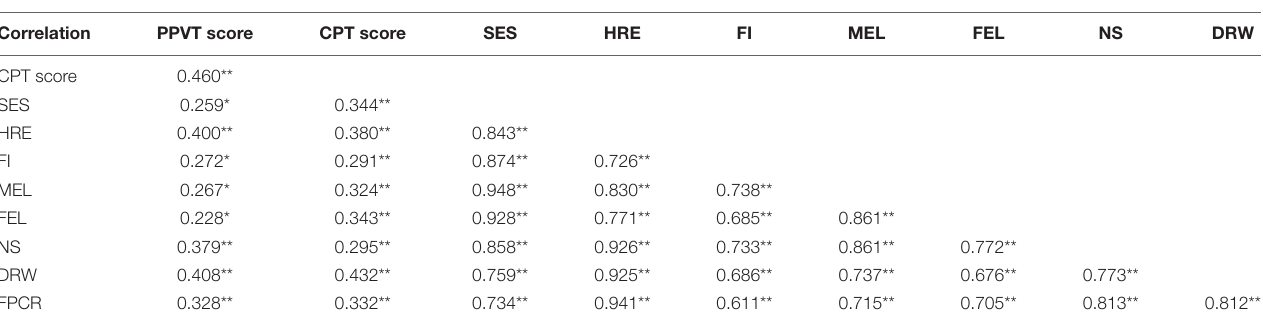
TABLE 3 | Correlations between behavioral